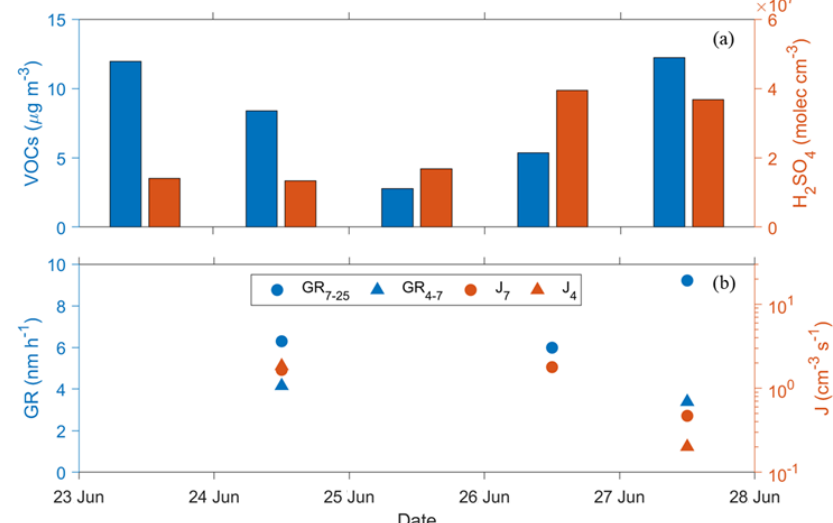
Figure 9. (a) VOCs and H 2 SO 4 concentration and (b) GR and J in different size ranges from 23 to 28 June observed at the SNS